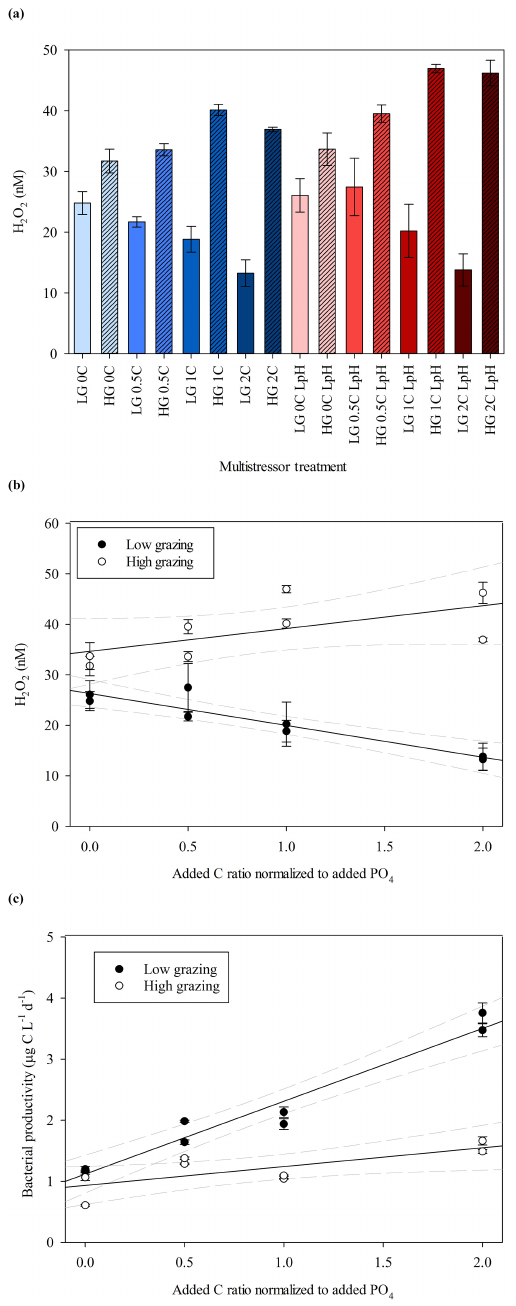
Figure 4. (a) H 2 O 2 concentrations at the end of the MultiMed ex- periment (day 9). Ambient pH (blue), low pH (red); high grazing (hashed); carbon (C) added at 0, 0.5, 1.0, 1.5 and 2.0 times the Red- field carbon: phosphate ratio. (b) Plotting both ambient- and low-pH data points together, which exhibited no statistically significant dif- ference in H 2 O 2 concentrations, final H 2 O 2 concentration showed contrasting trends between high- and low-grazing treatments over the added C gradient. The 95% confidence intervals are shown. (c) Bacterial productivity, measured via leucine incorporation, dur- ing the same experiments. Error bars show ± SD of at least triplicate